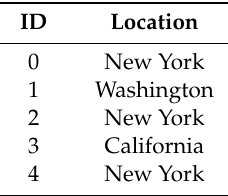
Table 2. Toy dataset with house ID and its location.